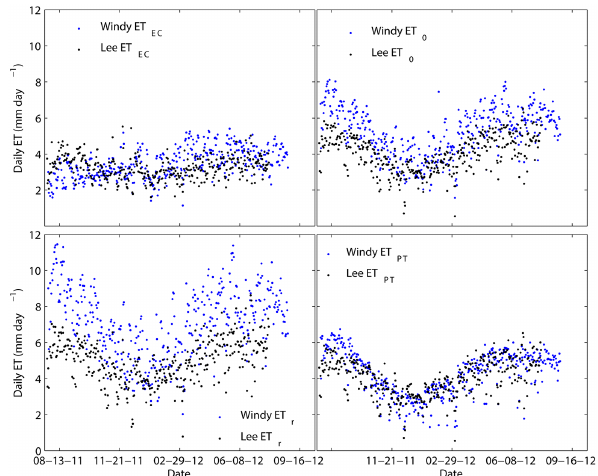
Figure 5. Cumulative measured and reference ET for Windy and Lee. Shaded background indicates mid-period when ground canopy cover exceeded